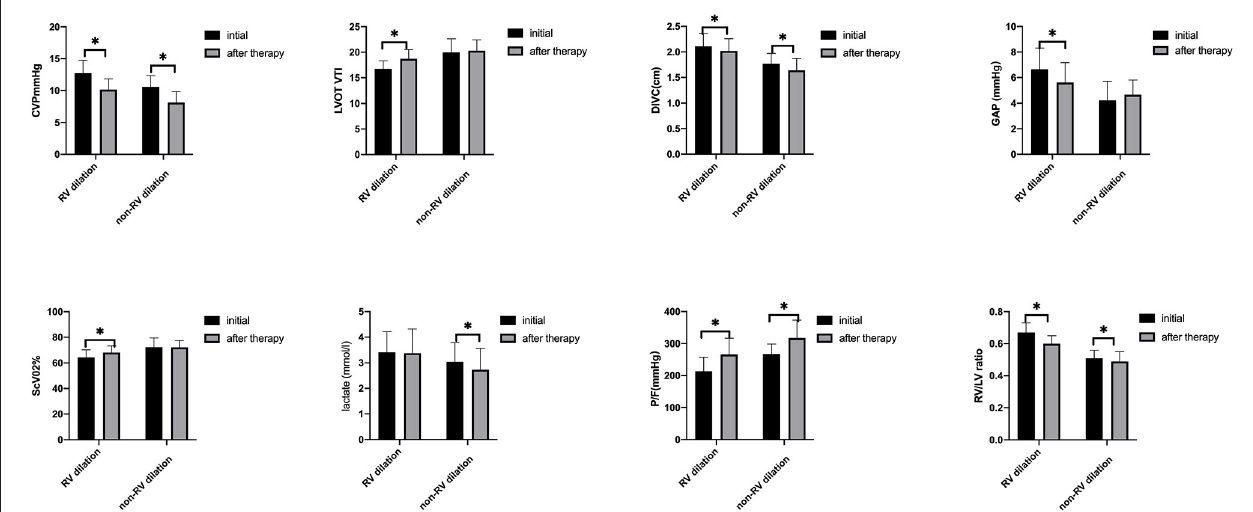
FIGURE 3 | Hemodynamic parameters between T0 and T1 in the two groups, *indicates a p < 0.05 between the two groups. CVP, central venous pressure; LVOT VTI, left ventricular outflow tract velocity time integral; DIVC end − expiratory , diameter of the inferior vena cava; P(V-A)CO 2 , central venous-arterial carbon dioxide difference; ScVO2, central venous oxygen saturation; P/F, arterial partial pressure of oxygen to fractional concentration of inspired oxygen; RV D /LV D ratio, right to left ventricular diastolic dimensions